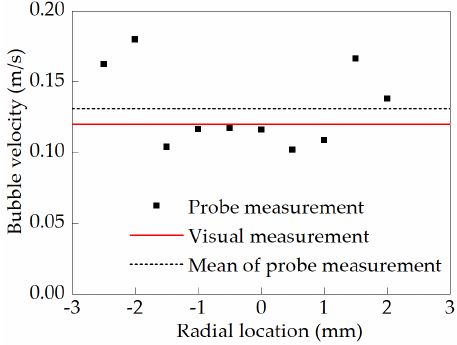
Figure 12. Bubble velocity from probe and visual measurement.